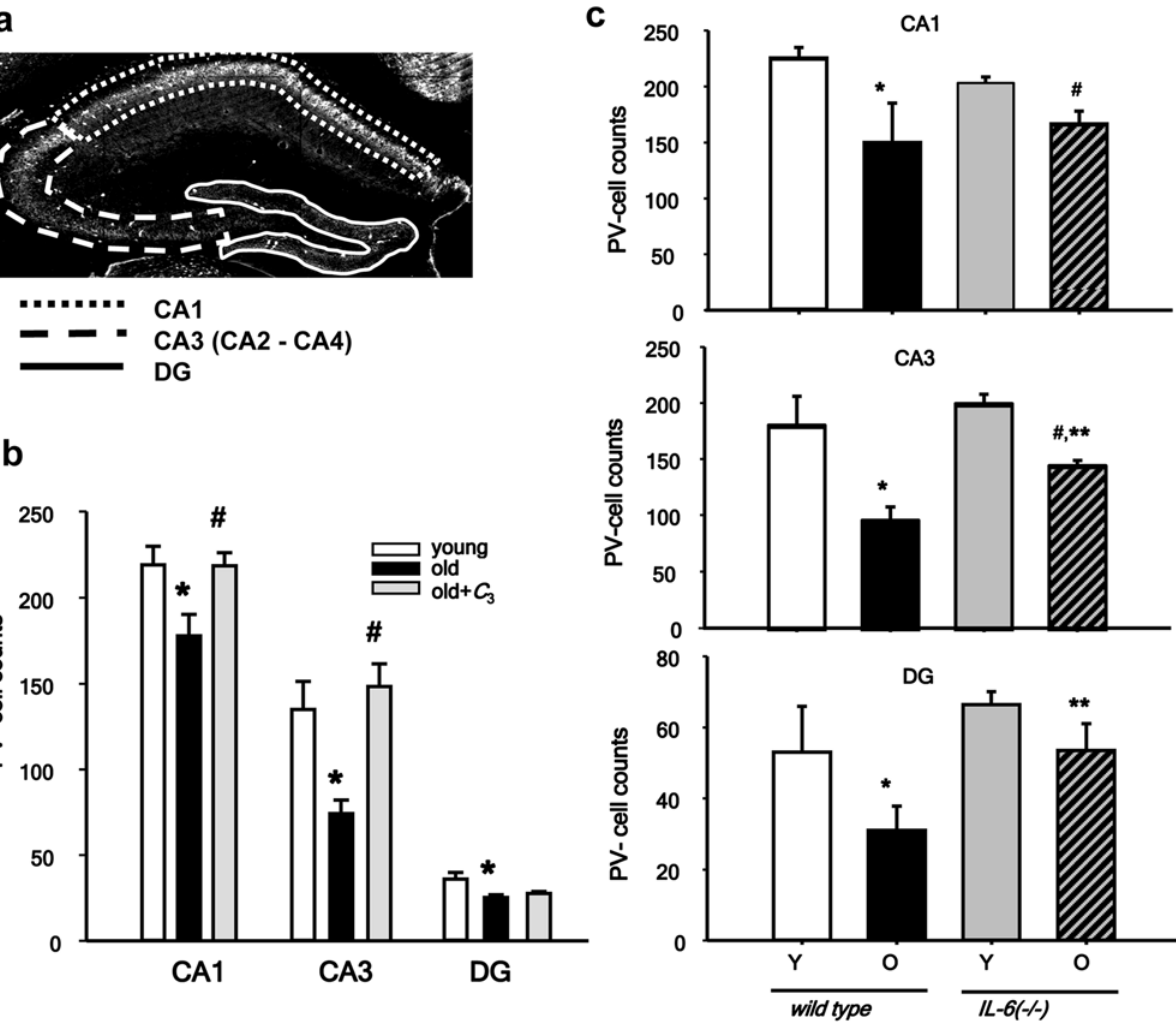
Figure 4. PV Interneurons are decreased with aging, but spared in IL-6 -/- mice or mice treated chronically with an SOD mimetic, C 3 . (a) Images, depicting the regions analyzed for PV-interneuron immunostaining in the prelimbic region (between Bregma 2.2 and 1.9), and dorsal hippocampus (between Bregmas 2 1.2 and 2 1.7). Four consecutive slices were analyzed for each animal. All cells in the regions were counted, and counts per slice were calculated as described in Methods (b) PV-cell counts in the regions of CA1, CA3 and dentate gyrus (DG) of old and old-C3 treated animals are expressed as % of their control. Aging was accompanied by a statistically significant decrease in PV-interneuron number in all regions analyzed and treatment of animals from middle age with the SOD-mimetic C 3 (Old- C 3 ) prevented the reduction of PV-interneuron numbers in CA1 and CA3, but not in DG. (c) The loss of PV neurons in all of the studied regions was partially rescued in IL-6 KO mice. * indicates statistical significance with respect to young animals (P , 0.05) and # indicates statistical significance with respect to old animals (P , 0.05) as determined by ANOVA followed by Tukey’s test. YM and OM: n=9 animals per group; OM + C 3 : n=7 animals.